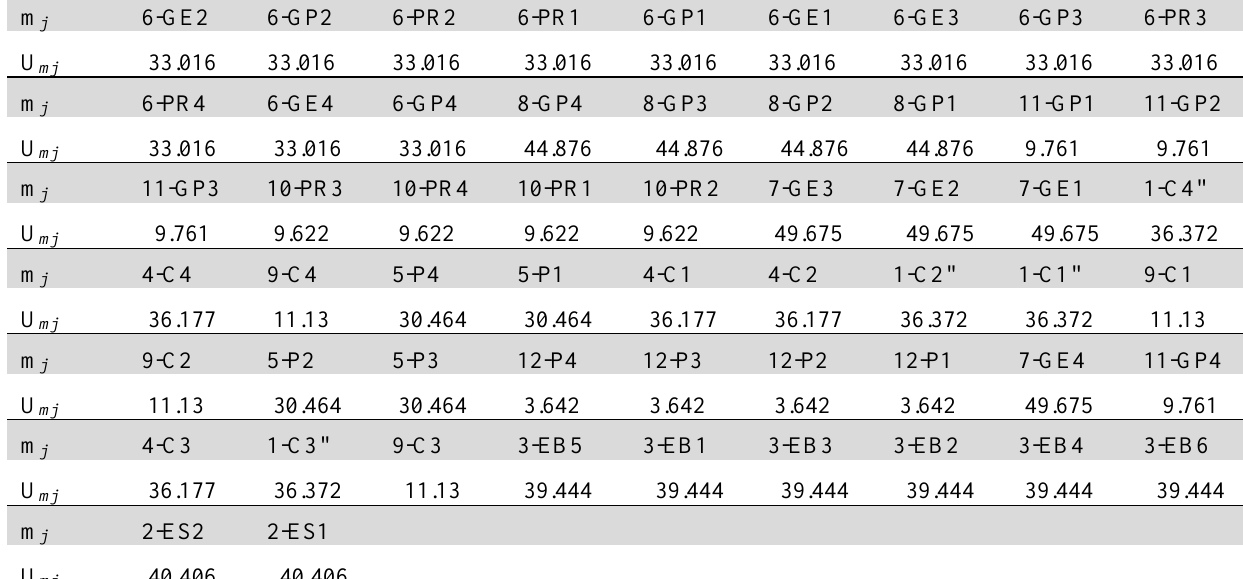
Results of optimal sequence of operation and associated cutting speeds for Case 1 using PSO m